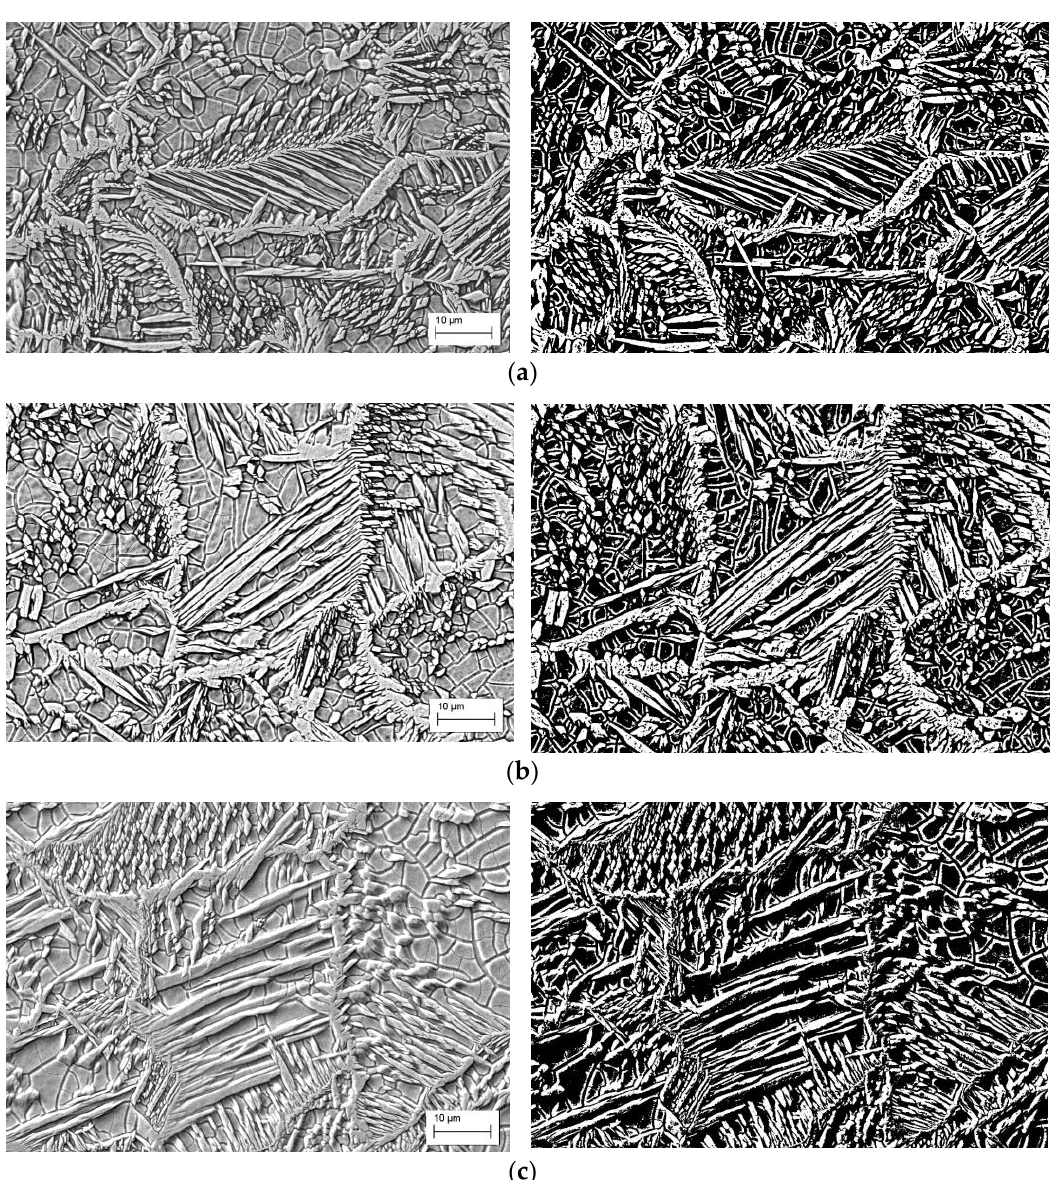
Figure 5. SEM micrographs and respective binary images of the fusion zone for: ( a ) 45 J / mm; ( b ) 90 J / mm; ( c ) 120 J / mm.